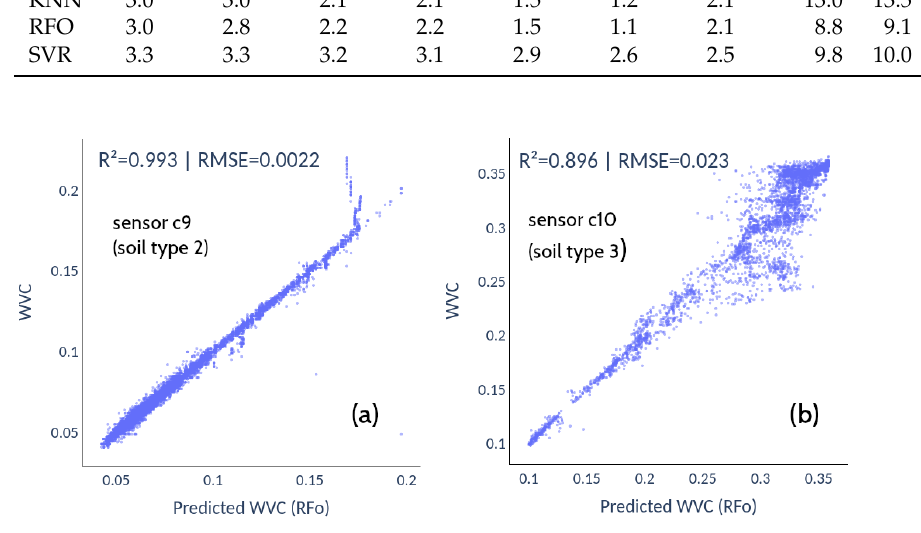
Figure 12. The best fits for each soil type were obtained with Random Forest (RFO) for sensors c9 ( a ) and c10 ( b